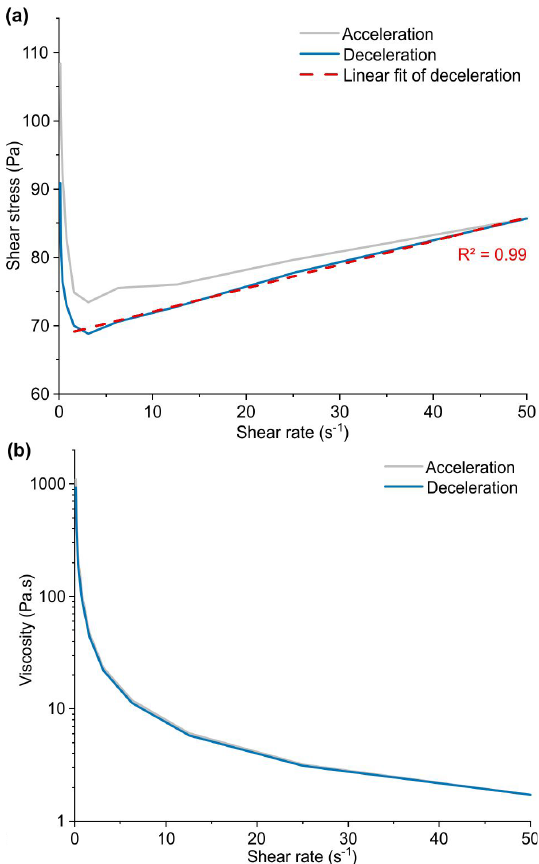
Figure 8. Shear stress (a) and viscosity (b) of the rehydrated paste as a function of shear